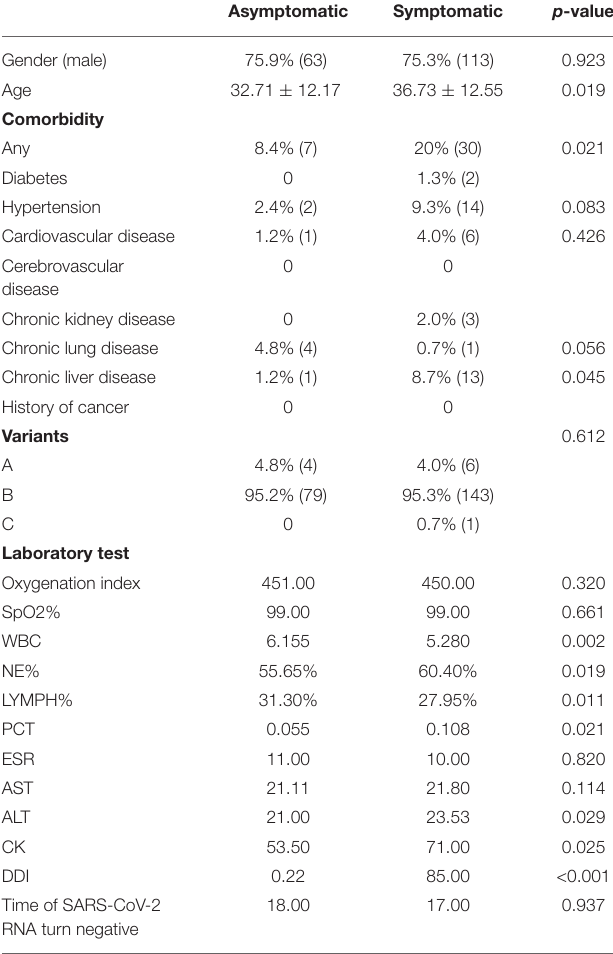
TABLE 1 | Clinical characteristics and time of SARS-CoV-2 RNA turning negative in asymptomatic and symptomatic